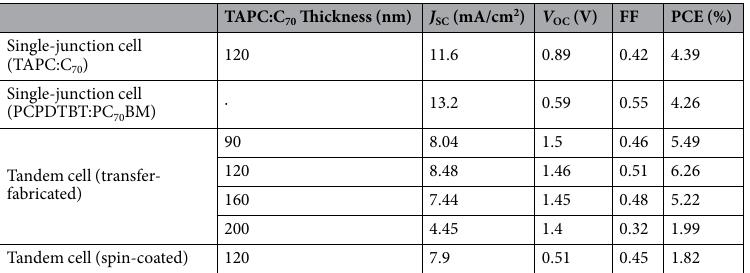
Table 1. Photovoltaic parameters of hybrid organic tandem solar cells with different thicknesses of the bottom active layer